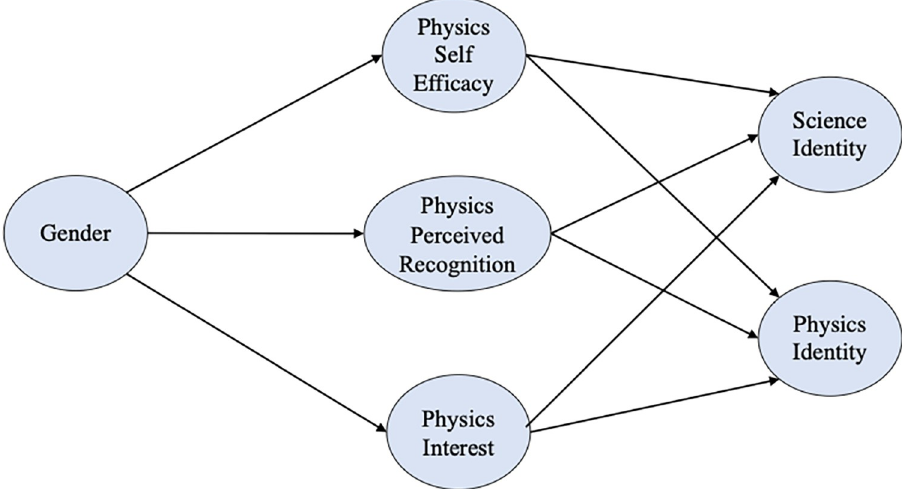
Fig 1. Schematic representation of the path analysis part of the model based on the theoretical framework. From left to right, all possible paths were considered. The regression paths from gender to physics identity or science identity are not shown since we did not find them to be statistically significant in our